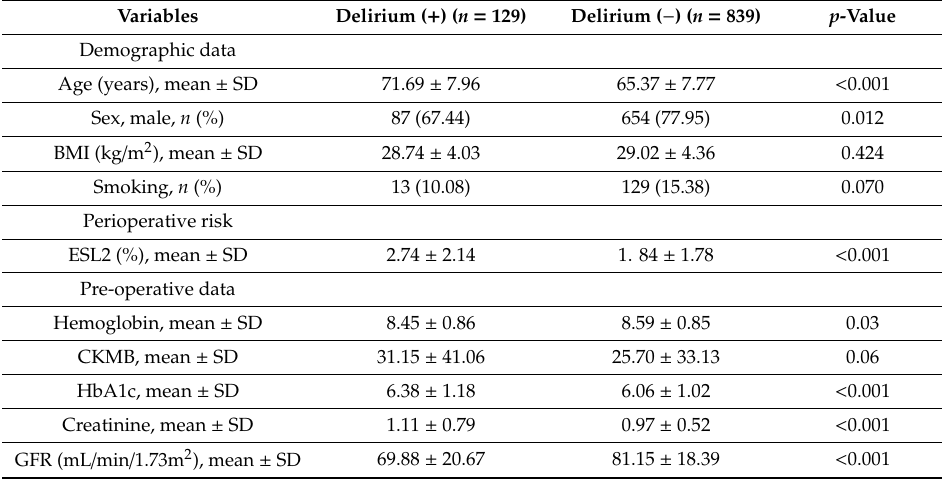
Table 1. Baseline characteristics and perioperative data for patients with and without Postoperative delirium (POD) after coronary artery bypass grafting (CABG). POD, Postoperative delirium; CABG, coronary artery bypass grafting.